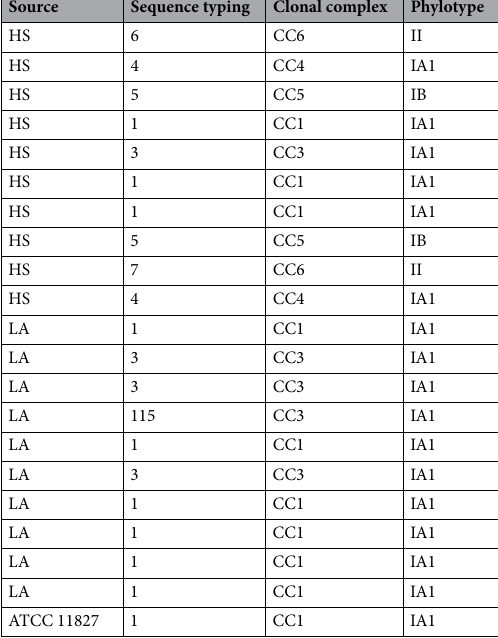
Table 2. Multilocus sequence typing (MLST) and phylotype profiles of the C. acnes strains isolated from the skin of healthy subjects (HS) and the lesional area of acne patients